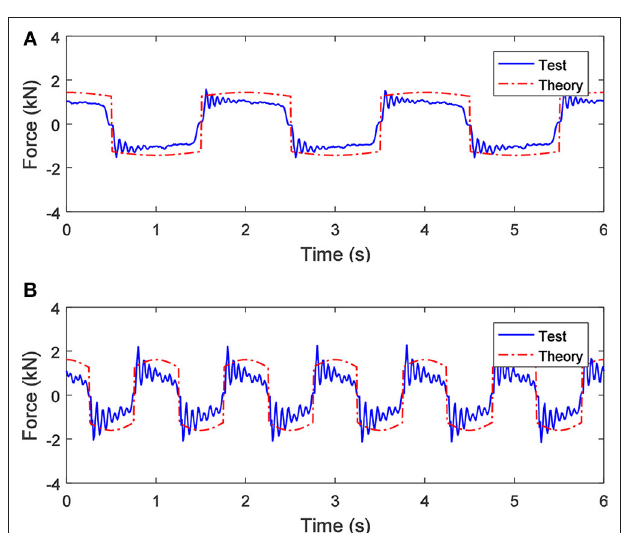
FIGURE 5 | When the applied current is 0.5A, the output force of the SAI under sinusoidal displacement excitations with an amplitude of 20mm and different frequencies: (A) 0.5Hz and (B)